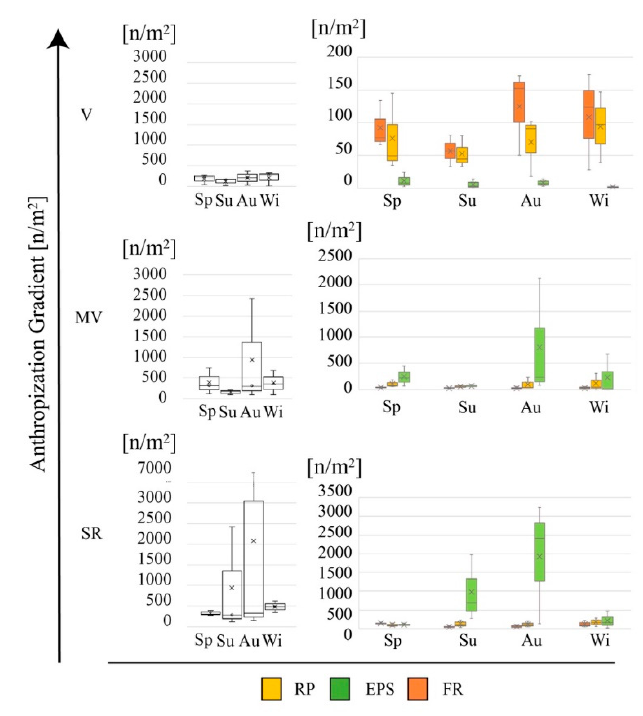
Figure 3. Distribution of MP density, expressed in number of items for square meter (n / m 2 ) per site (SR, MV, V): considering the 3 MP types together on the left, and separated on the right. (Sp = spring, Su = summer, Au = autumn, Wi = winter).